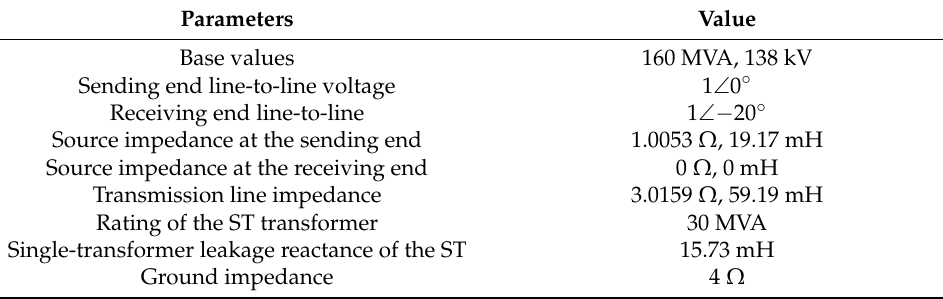
Table 2. The main parameters and settings for the case